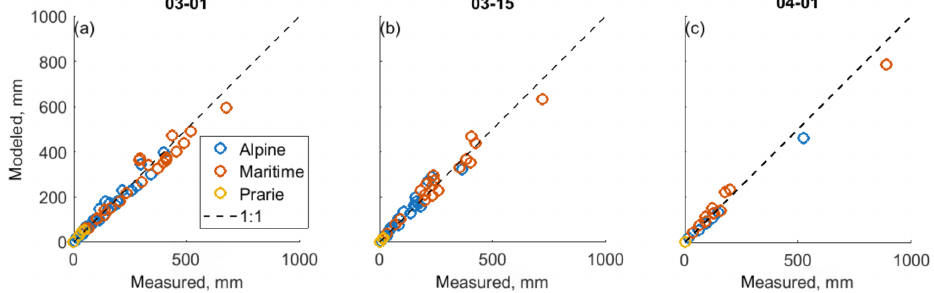
Figure 5. Model vs. measured SWE at all stations for selected dates in 2017.